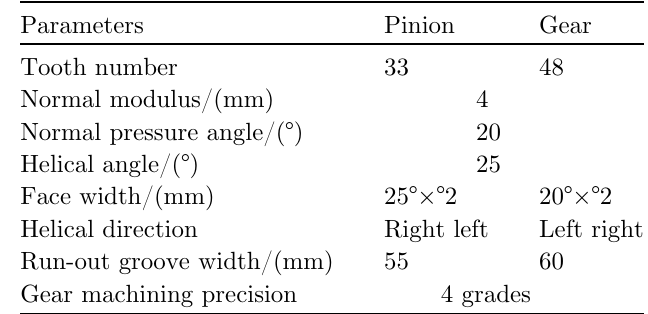
Table 2. Parameters of experimental double helical